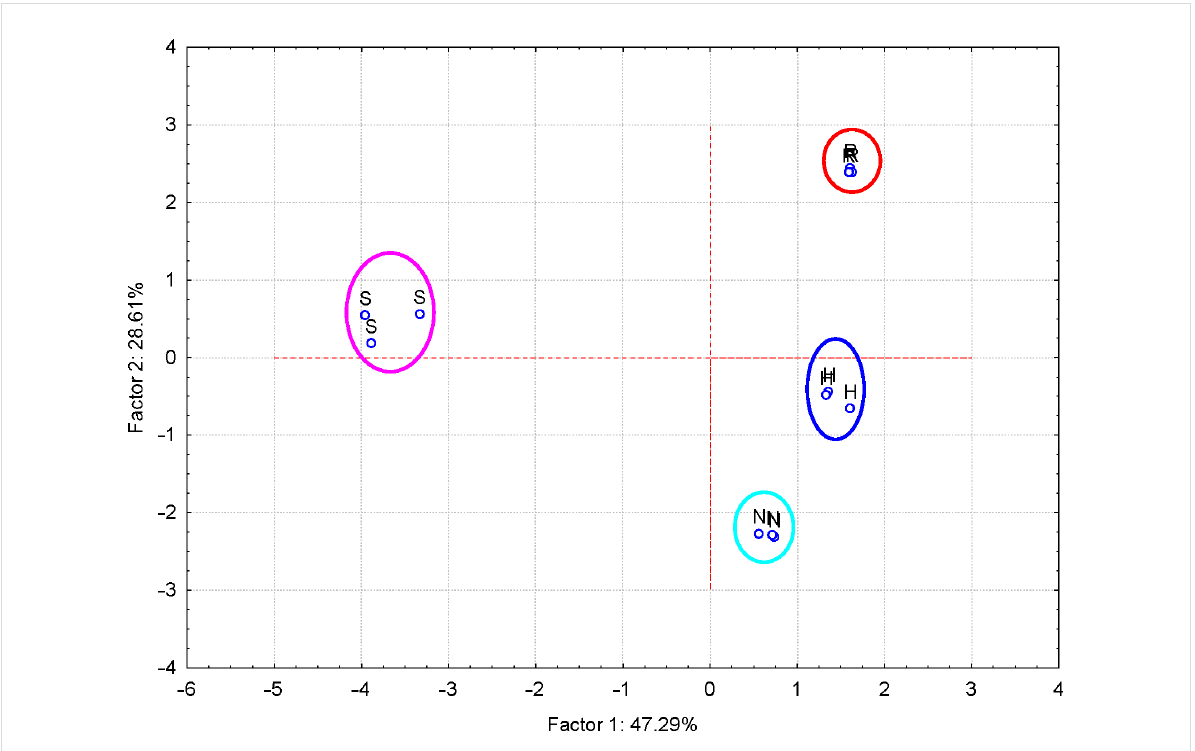
Figure 4: PC 2 versus PC 1 scores plot from the FTIR–PCA analysis of the flavonoid glycoside and flavonolignan antioxidants (codes: “H” – hesperidin, “N” – naringin, “R” – rutin and “S” – silymarin); only wavenumbers of the FTIR bands were used as input